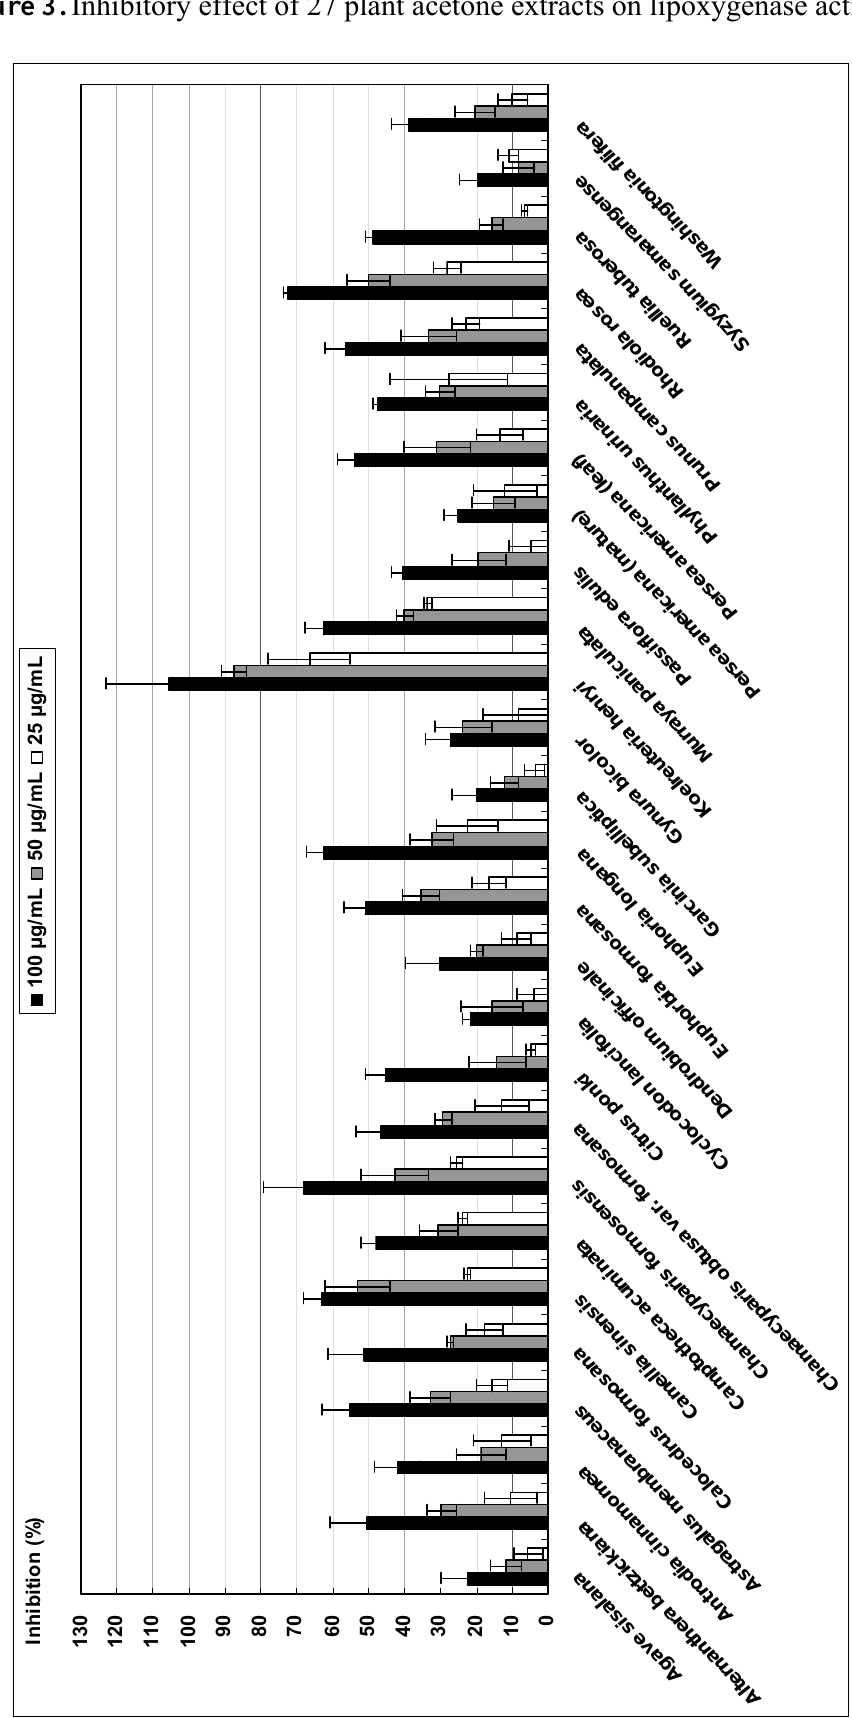
Figure 3. Inhibitory effect of 27 plant acetone extracts on lipoxygenase